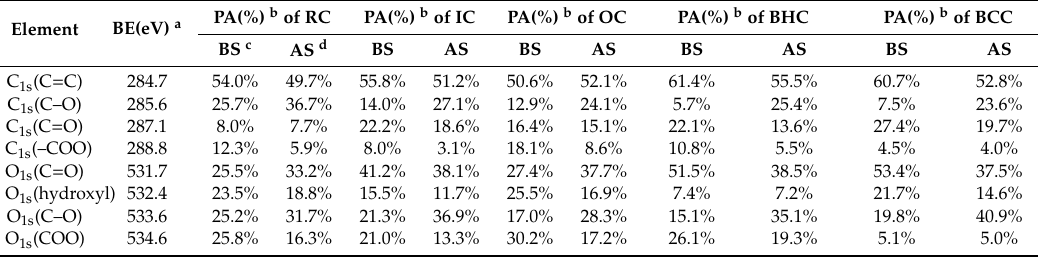
Table 2. Elemental binding energy and mass content of different biochar components before and after Hg 2+ adsorption.